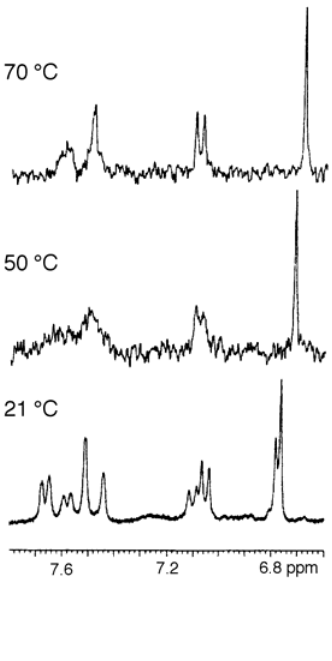
Figure 8. Variable temperature 1 H-NMR spectrum of 6,8-di- C -glucosyl diosmetin ( 32 ), recorded in DMSO- d at 300 MHz. See ref. 6